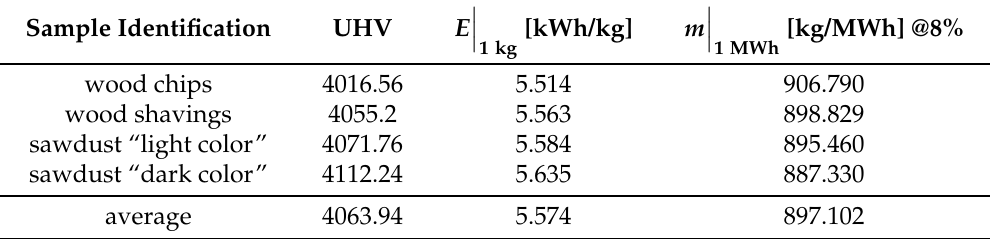
Table 7. Amount of raw material (kg) required to generate 1 MWh of effective energy using briquettes at 8% moisture